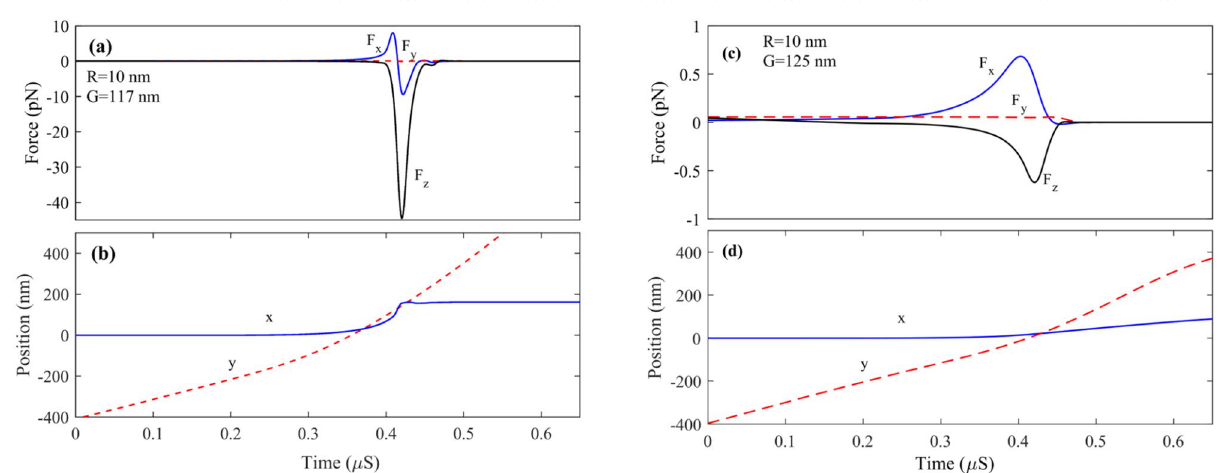
Figure 9. ( a , b ) Force and position as a function of time for a nanoparticle with R = 10 nm and G = 117 nm, respectively. ( c , d ) Force and position as a function of time for a nanoparticle with R = 10 nm and G = 125 nm